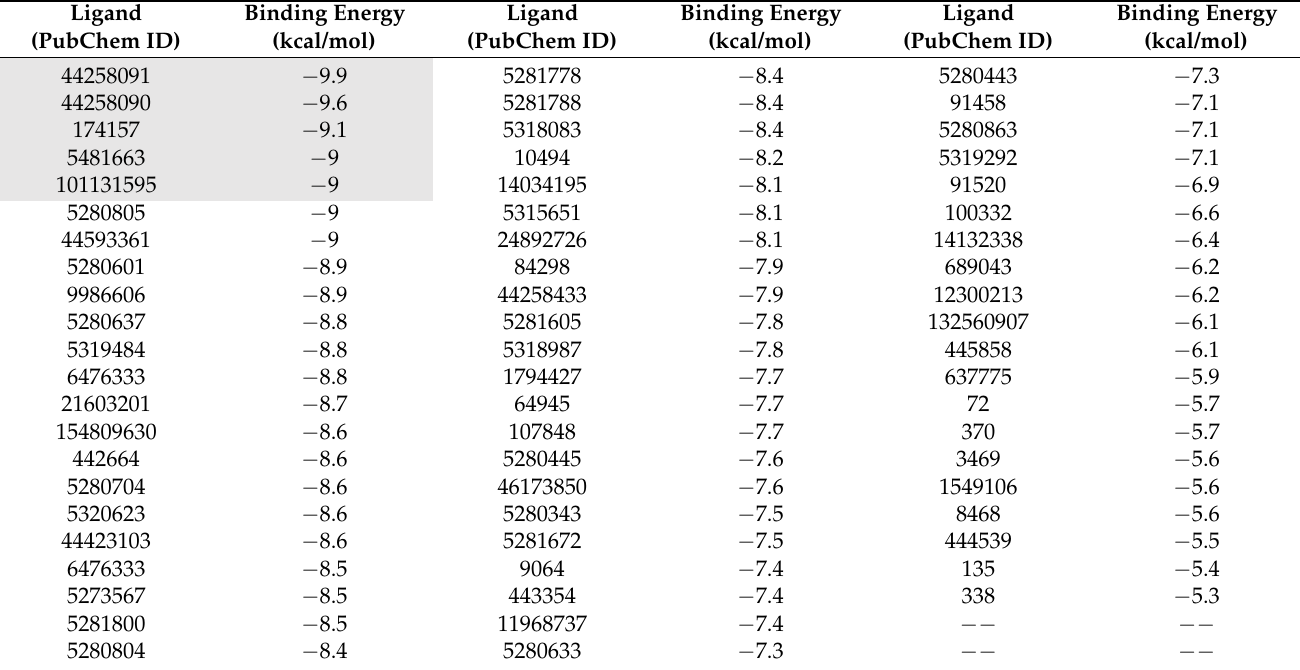
Table 1. Binding energies were calculated using Pyrx for 65 P. lanceolata compounds screened against the A42R protein of MXV. Top five hits are